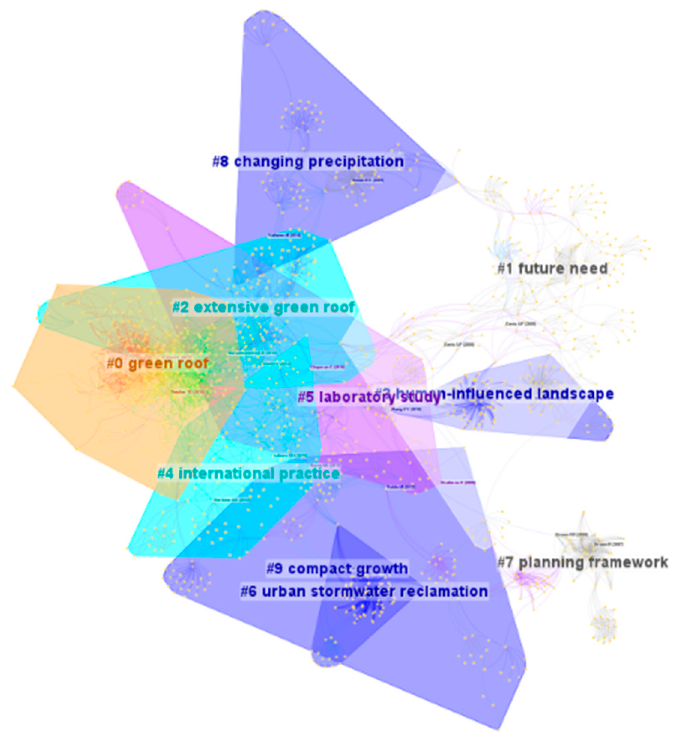
Figure 8. Cluster map for urban rainfall runoff management research.